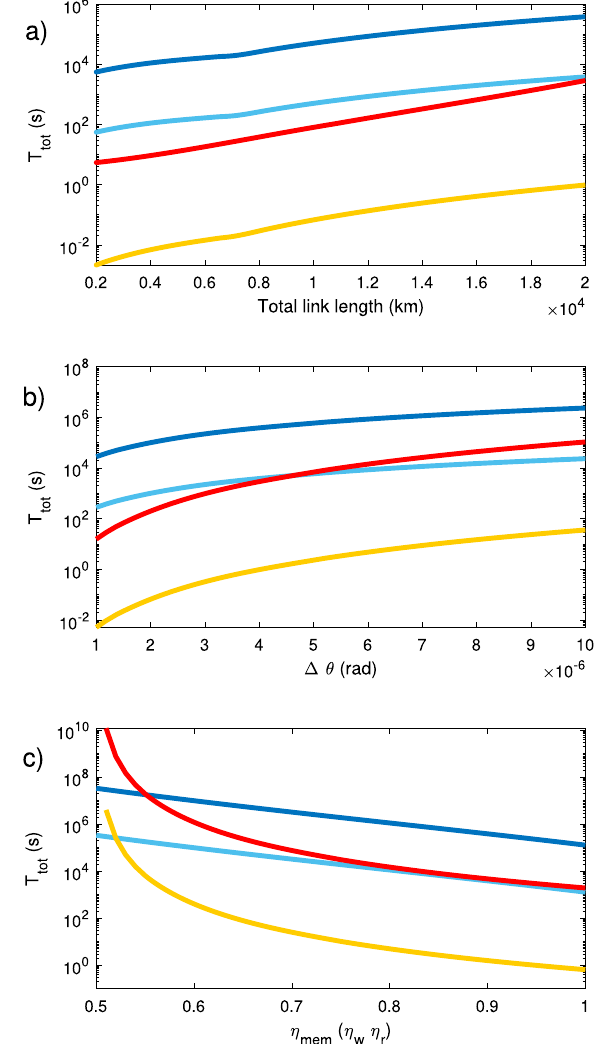
Fig. 2 Time to distribute an entangled pair as a function of different parameters. a total distance, b beam divergence and c memory ef fi ciency. Within each plot: DLCZ with single (dark blue) or 100 mode (light blue) memory, hybrid-QND (red) and space-QND protocols (orange). The nominal assumed parameters (when not varied) are nonideal Gaussian beams with divergence Δ θ = 4 μ rad, L η ≡ η = 0.9, with η = η fi x η = 0.9, η = 20,000 km and η r w mem r w . We q s = 1, R s = 20 MHz and an average fcc = 0.54.